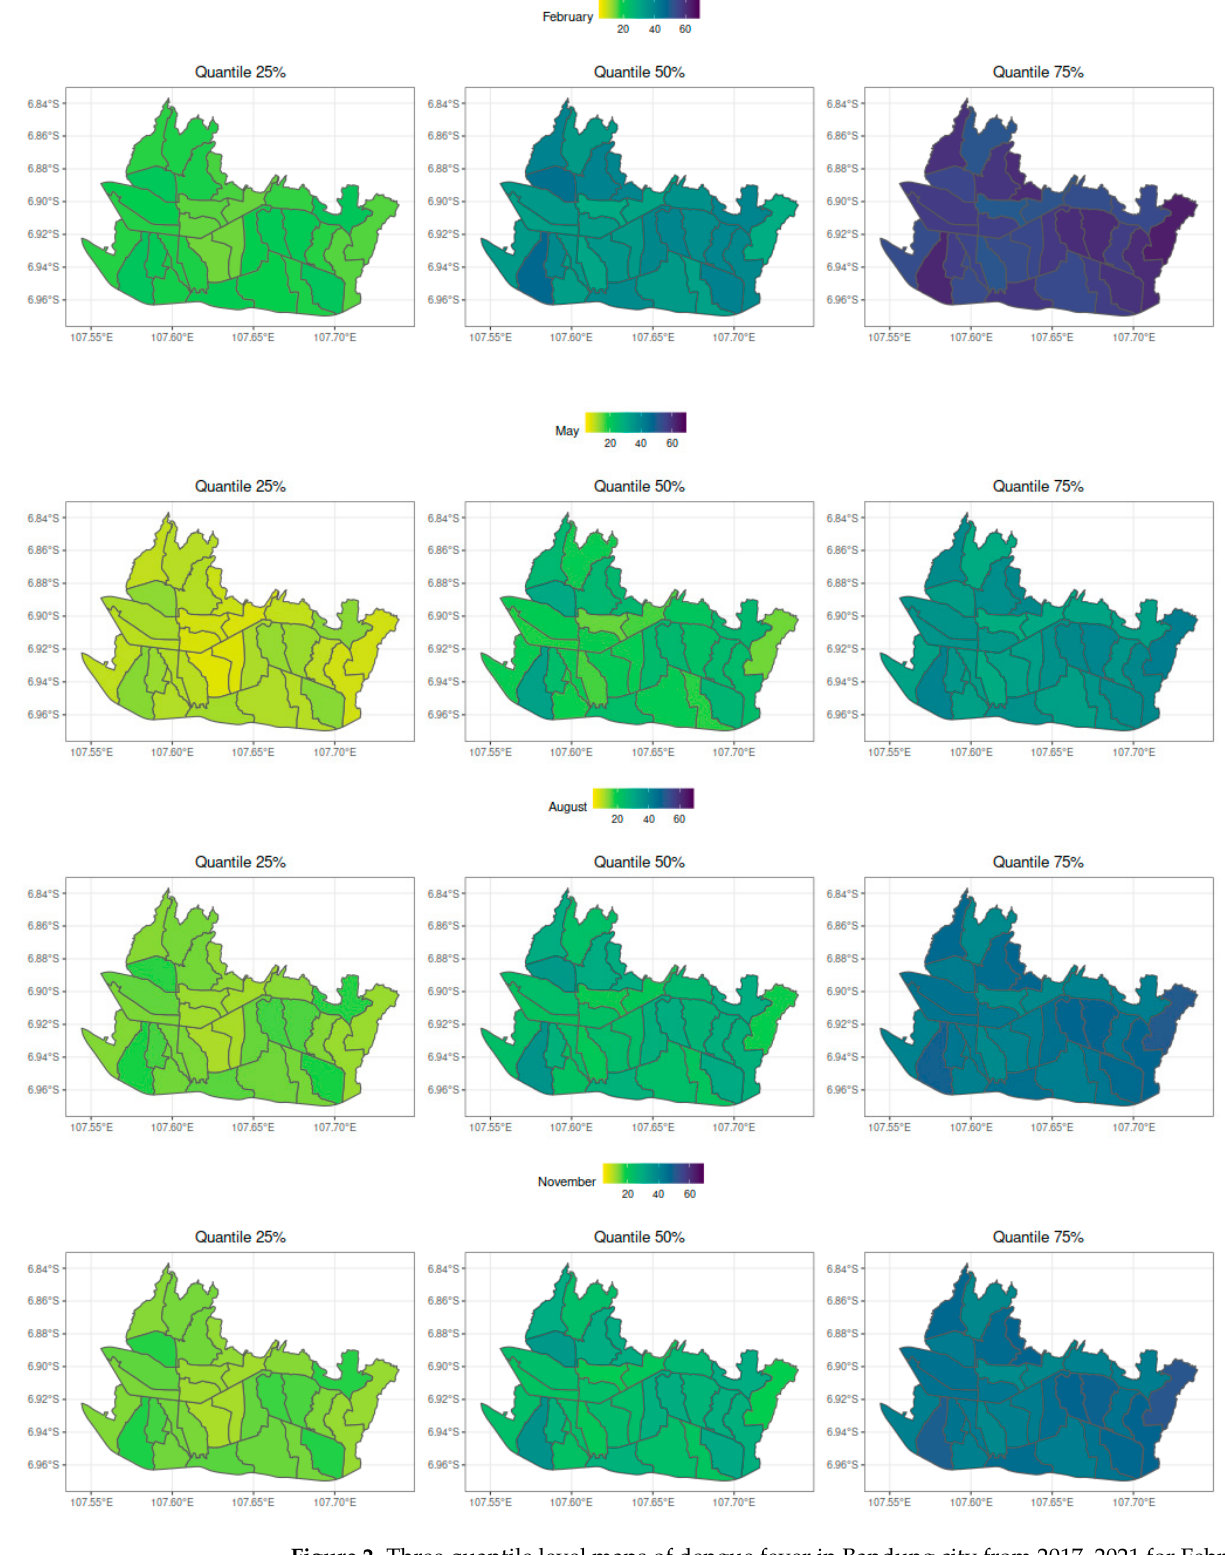
Figure 2. Three quantile level maps of dengue fever in Bandung city from 2017–2021 for February, May, August, and November.